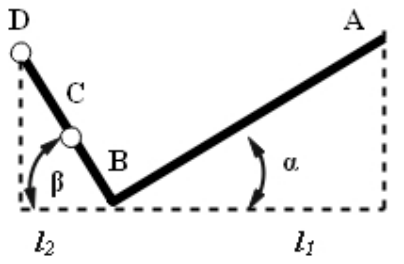
Figure 9. Parametric model of the key energy-absorbing structure of the seat.